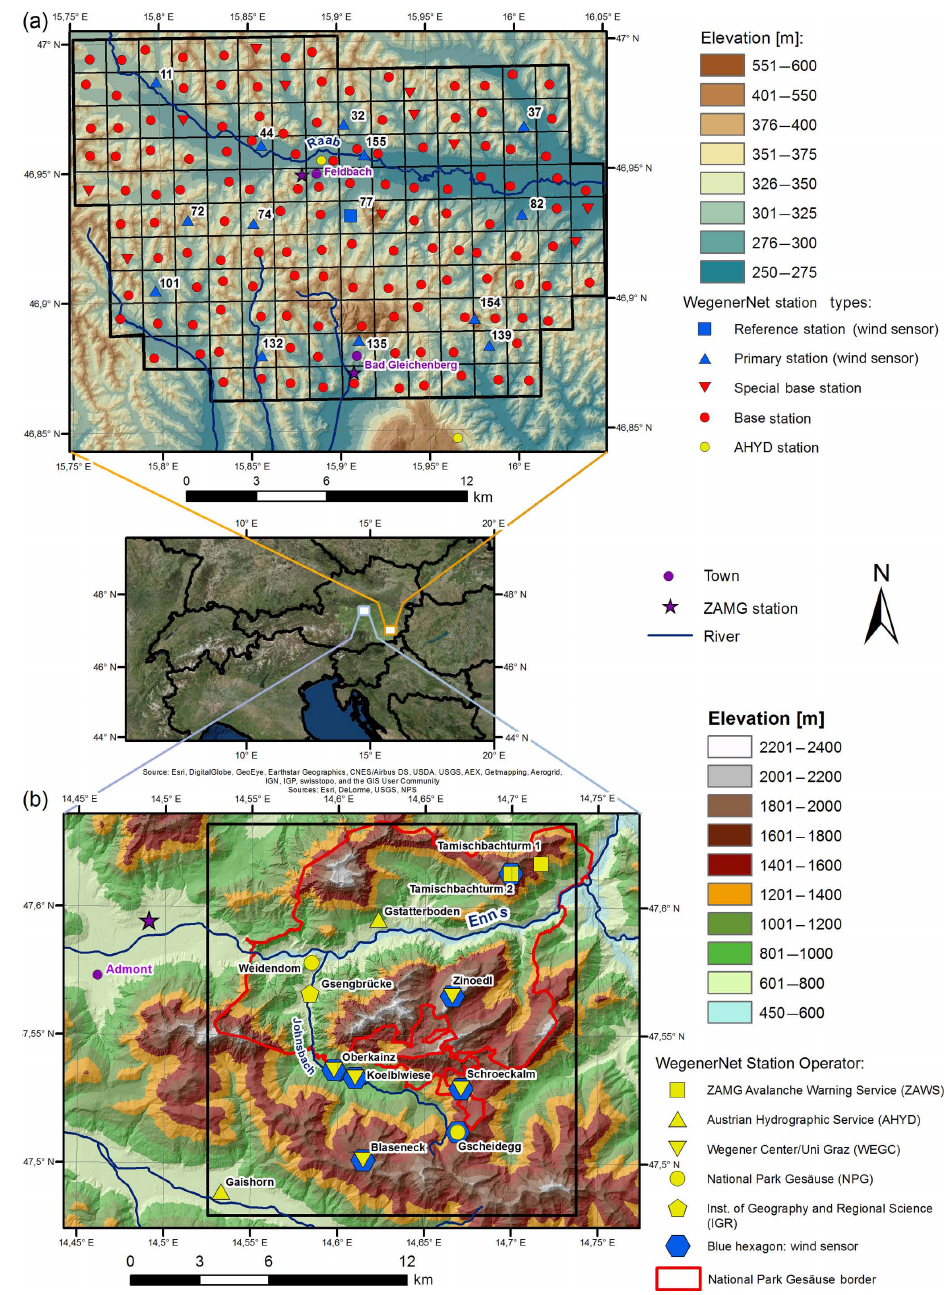
Figure 1. Location of the study areas in Austria (small middle panel between a and b ), the WegenerNet Feldbach Region (FBR) in the southeast of the state of Styria and the WegenerNet Johnsbachtal (JBT) region in the north of Styria (white rectangles, enlarged in a and b ). (a) The WegenerNet FBR with its 155 meteorological stations, with the legend explaining map characteristics and station types. (b) Map of the WegenerNet JBT region (black rectangle) including its meteorological stations, with the legend explaining map characteristics and station